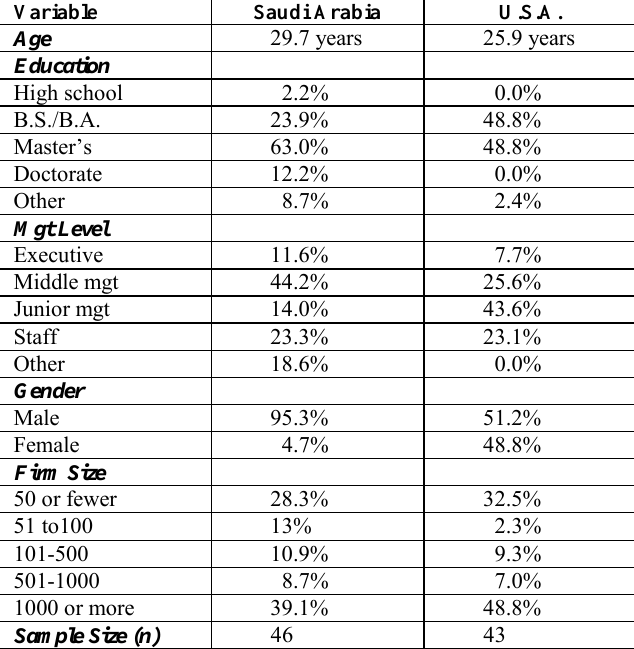
Table 1: Demographic profile of